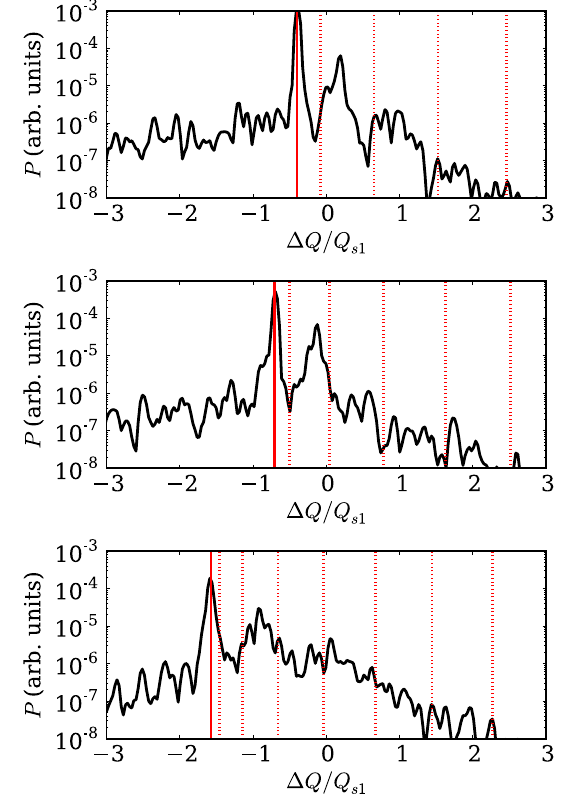
FIG. 4. Tune spectra obtained from the simulation for q c ¼ 0 : 15 q sc and